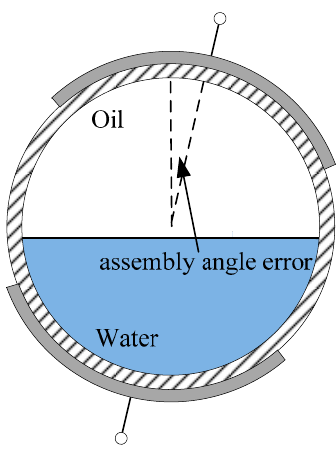
Figure 10. Sketch of assembly angle error during sensor installation. Table 1. The phase shift output ( ϕ ) of CCS with change in assembly angle error (using the optimized parameters).